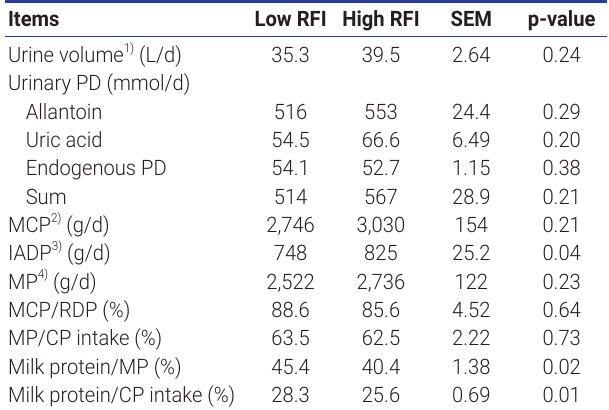
Table 3. The urinary purine derivatives and estimated metabolizable protein supply to the dairy cows selected for phenotypic divergence